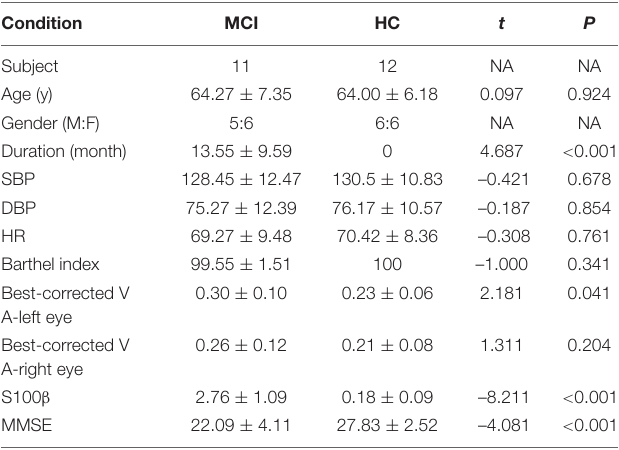
TABLE 2 | Demographic characteristic of the enrolled